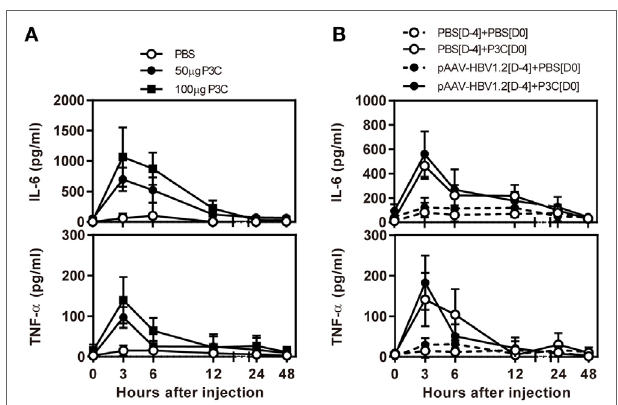
FigUre 1 | P3C treatment leads to the production of pro-inflammatory cytokines IL6 and tumor necrosis factor- α (TNF- α ) in vivo with and without hepatitis B virus (HBV) replication. (a) C57BL/6 mice were treated once with 50 or 100 µg of Pam3CSK (P3C) or phosphate-buffered saline (PBS) subcutaneously administered at day 0. (B) C57BL/6 mice received hydrodynamic injection with plasmid pAAV-HBV1.2 4 days (D-4) before P3C treatment, followed by a single SC injection with 50 µg of P3C or PBS at day 0 (D0). The serum levels of the pro-inflammatory cytokines interleukin-6 and TNF- α were measured using specific ELISAs. Data were analyzed using an unpaired Student’s t test. Statistically significant differences between the groups are indicated as * P < 0.05 and ** P <